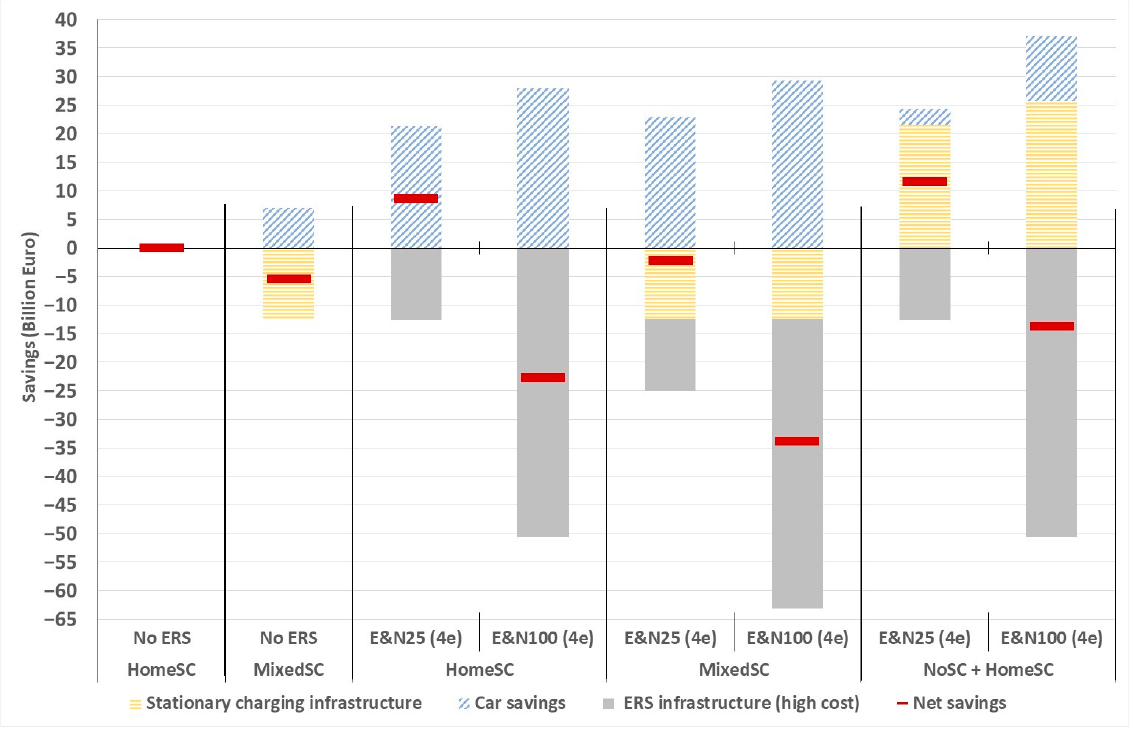
Figure 7. Car and charging infrastructure savings, ERS costs, and the resulting net savings for different combinations of stationary charging and ERS compared to the base case (left), assuming an ERS charging power rate of 4 e , the high value for the ERS investment cost, and 100% of the fleet adapted to ERS.